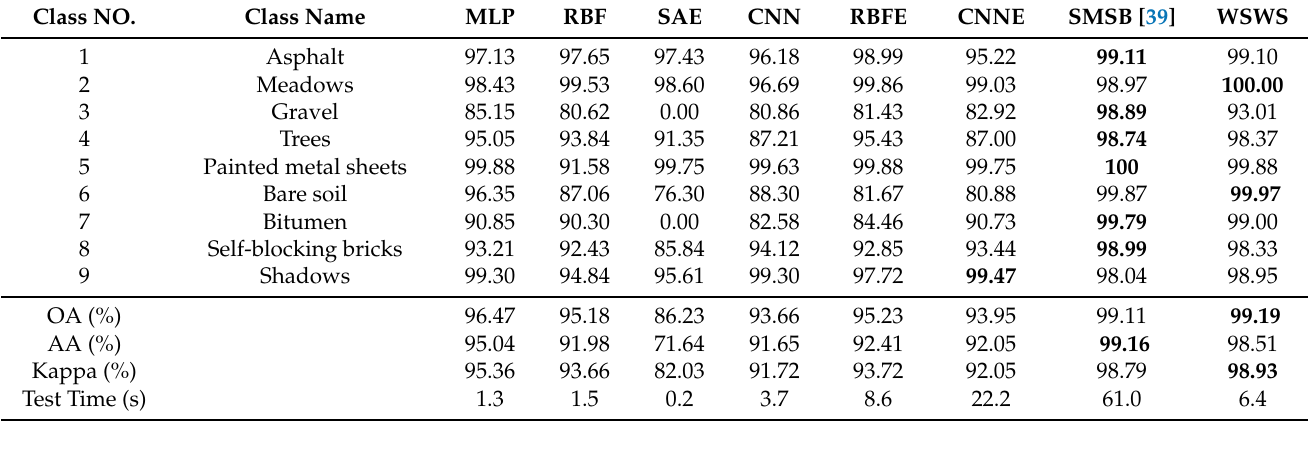
Table 3. Classification results of different methods for Pavia University.